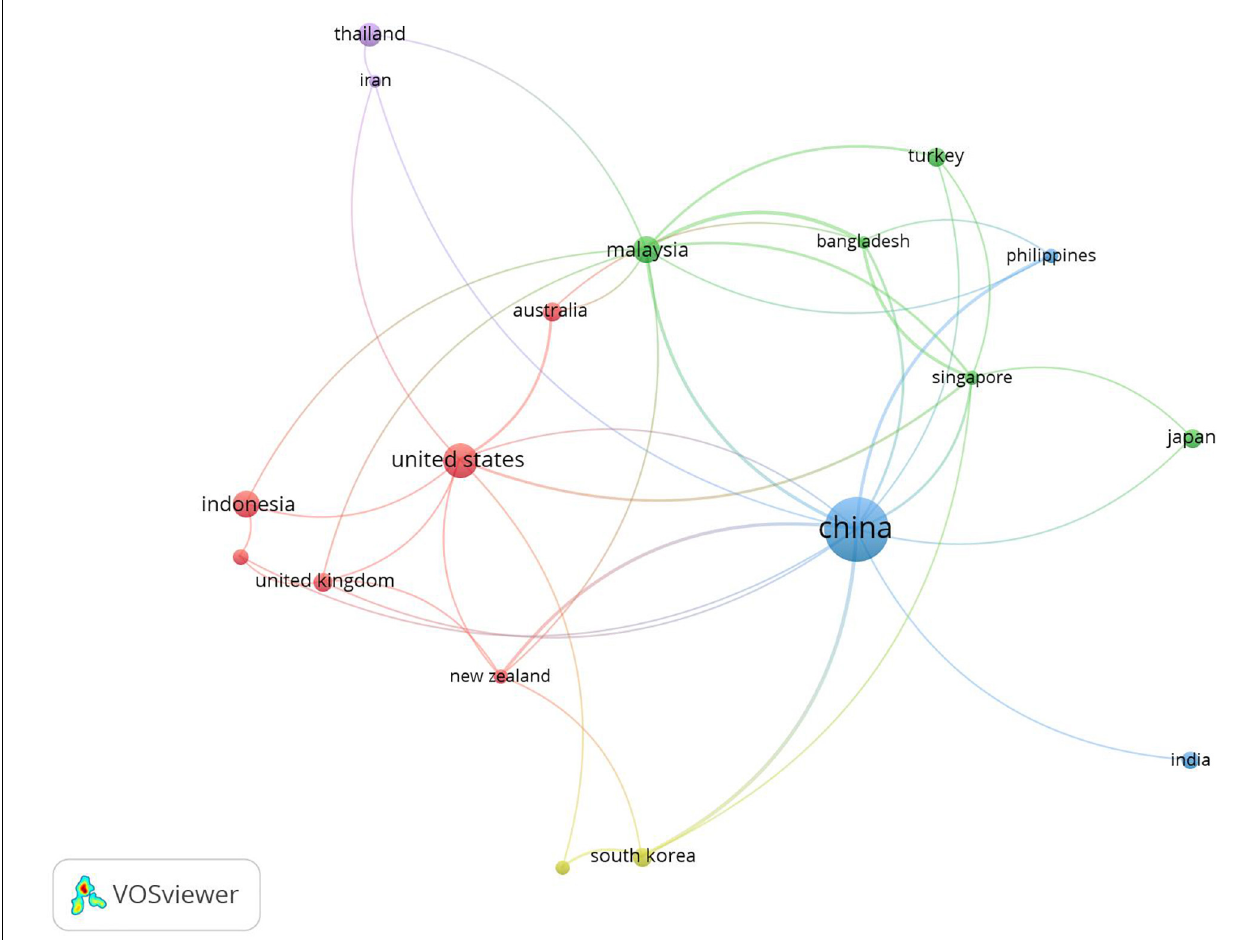
FIGURE 4 | Country co-authorship in the field of English speaking teaching and